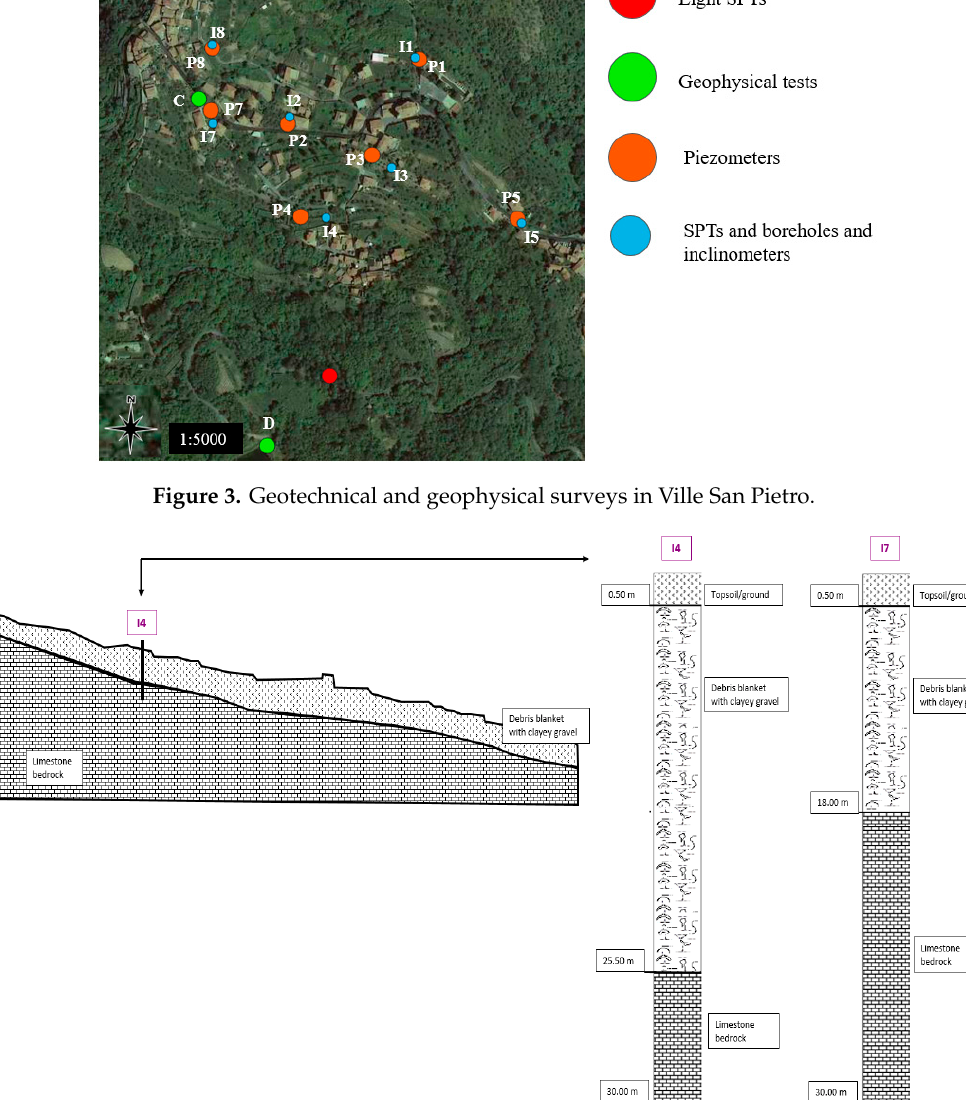
Figure 4. Stratigraphy profile and boreholes at I4 and I7.